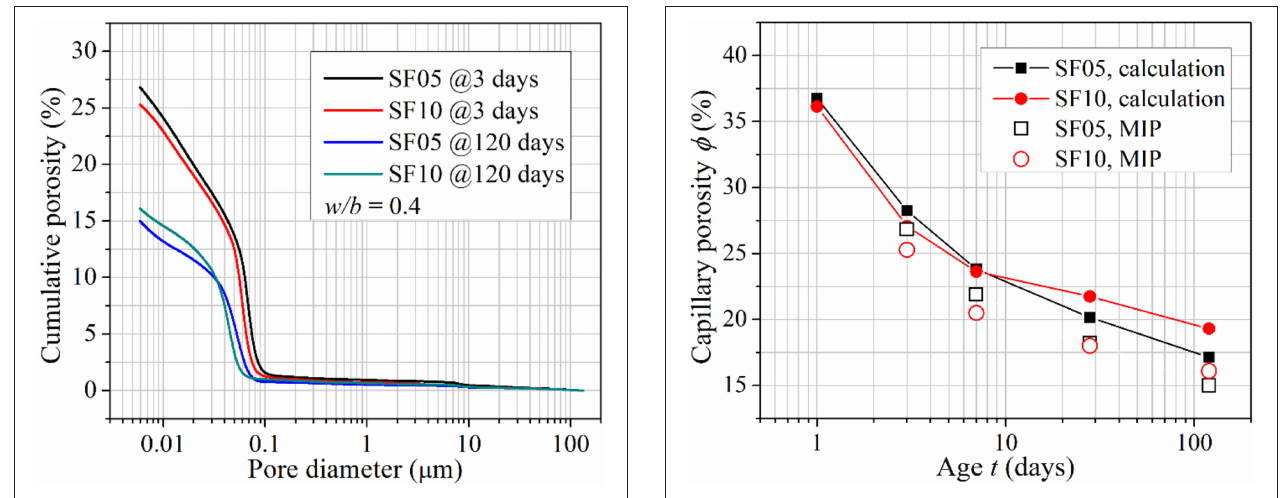
FIGURE 10 | Comparison of calculated and measured capillary